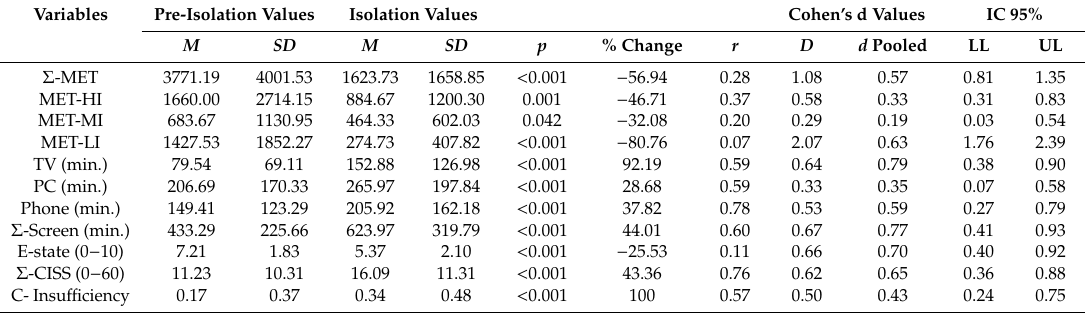
Table 1. General di ff erences between isolation and pre-isolation